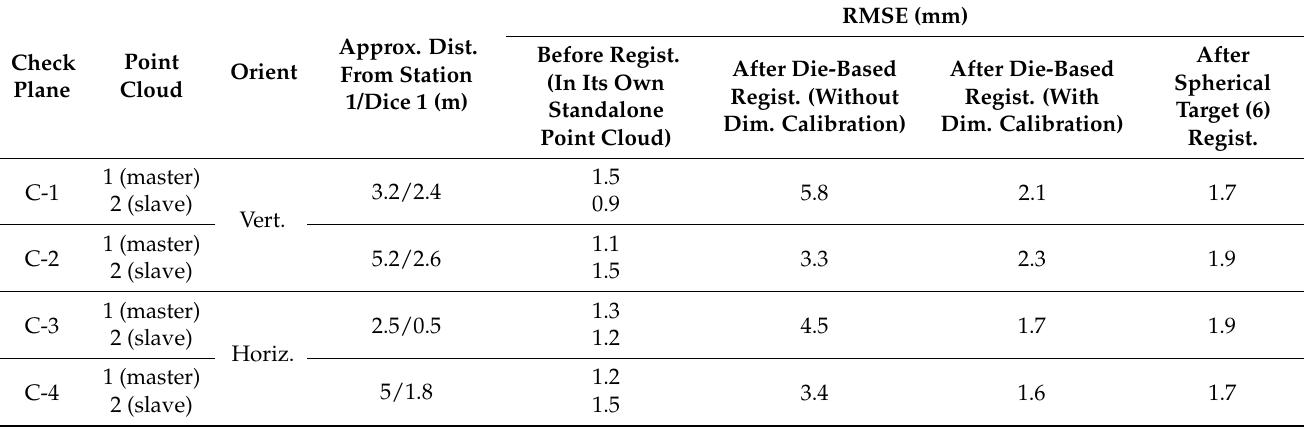
Table 4. RMSEs of check plane residuals before and after the registration. (Dataset C, die dimension = 50 cm × 50 cm × 50 cm).